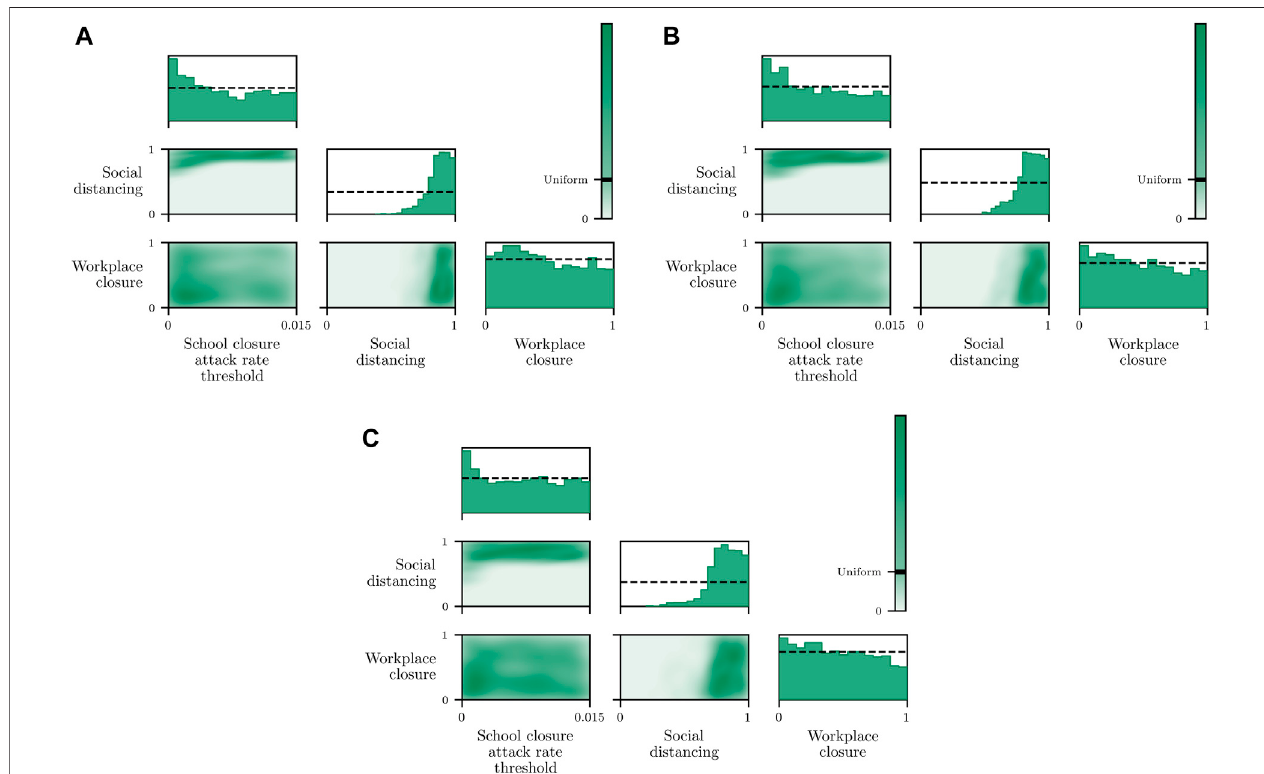
FIGURE 11 | Empirically determined marginals of the full posterior distribution over controllable policy parameters that give rise to appropriately controlled outcomes ( see Eq. 7 ) for simulations of COVID-19 of/in the Seattle metropolitan area. Similar to Figure 8 , the diagonal of each fi gure shows one-dimensional marginals for each policy parameter, with the uniform prior indicated by the dashed line. The remaining array of plots shows kernel density estimation (KDE) plots fi tted to samples from the two-dimensional marginals of the joint posterior distribution. For reference, the color corresponding to a uniform prior on the two-dimensional plots is indicated on the color bar on the right. Each of the Sub fi gures (A-C) shows the results of simulations for a different time period as indicated. The initial parameters and policygoalsfor each plotarereported in Table3 . Wesee thatamongthethree policyparameters,socialdistancingisthe mosteffective inalltimeperiods.Furthermore, puttingamorerestrictivepolicyonclosingschoolsorworkplacesleadstoawiderrangeofacceptablesocialdistancingpolicies.Finally,notethatintheJune2021-June 2022 period, when the vaccination rates are high, a looser set of policy enforcements is acceptable even though the desired outcomes for this experiment are much tighter ( see Table 3